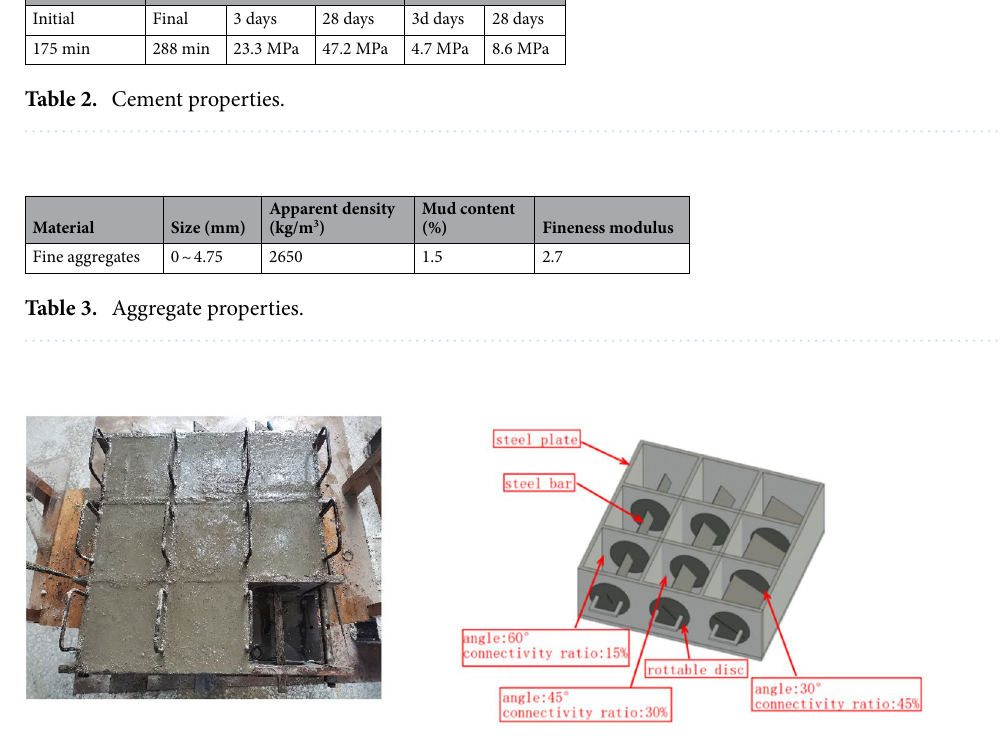
Figure 1. Mold used for preparation of fractured specimens of soft rock-like material.